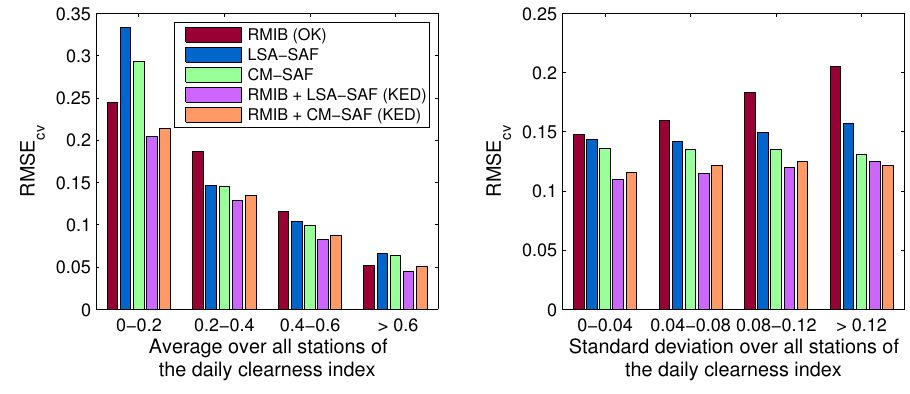
Figure 2. Distribution of the cross-validation root mean square error RMSE cv as a function of sky conditions. Sky-type classification is made upon the average (left-hand plot) as well as the standard deviation (right-hand plot) over all stations of the daily clearness index. The SAFs’ products are used at the finest spatial resolution (i.e., MSG pixel resolution for the LSA-SAF and 3 × 3km resolution for the CM-SAF). The results obtained with RK are not represented since they are virtually identical to those of KED. 4